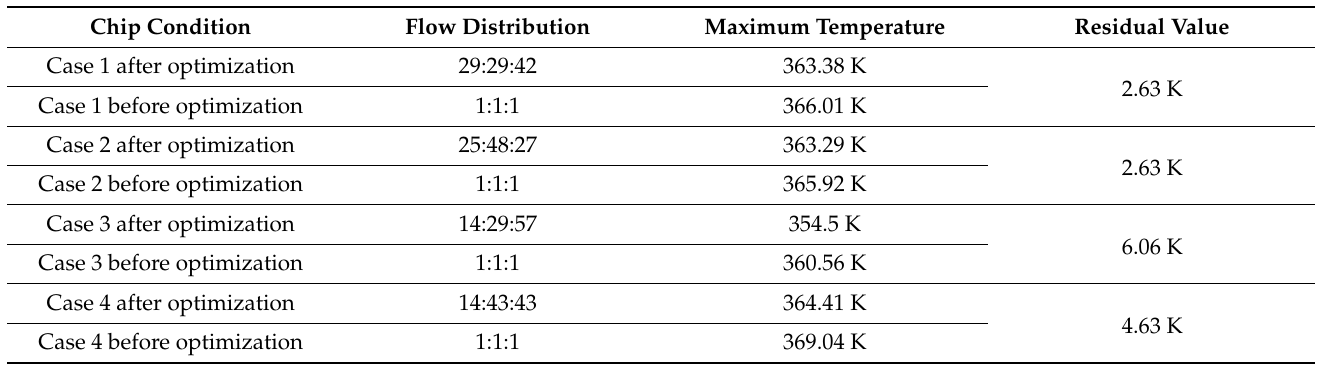
Table 2. Chip operating conditions.